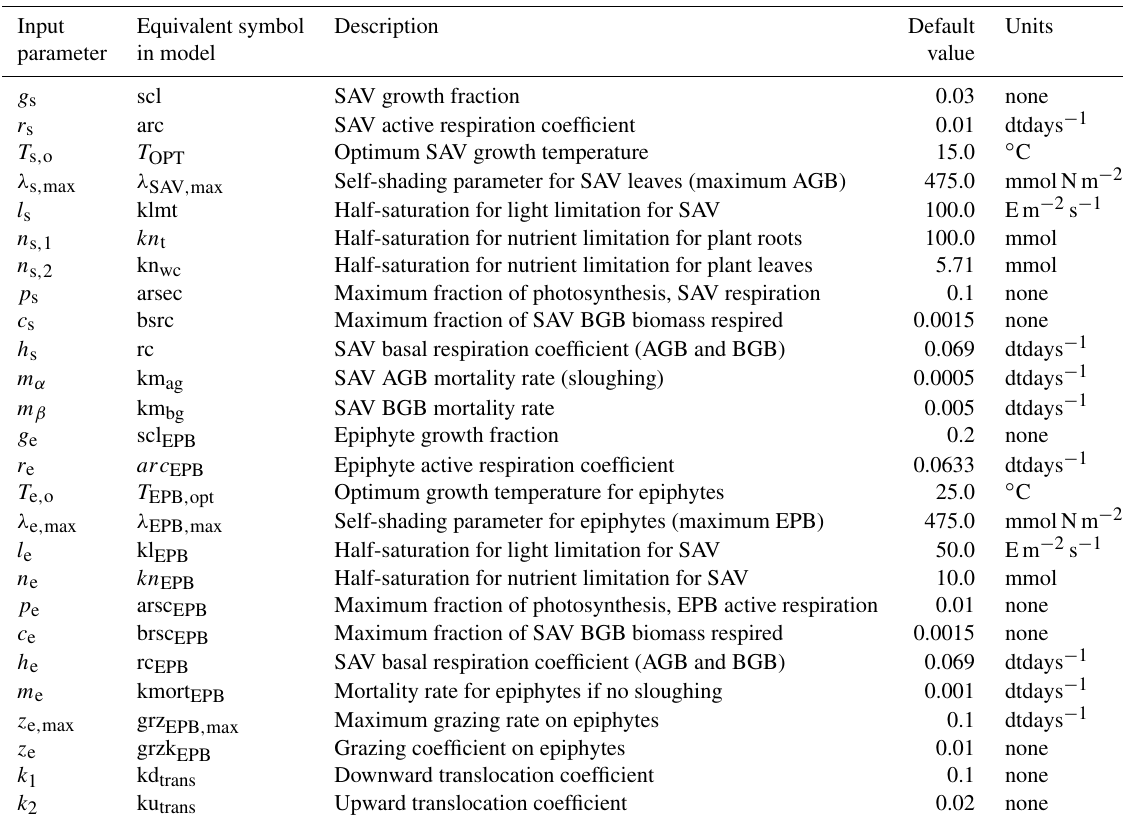
Table 2. SAV growth model input parameter descriptions and their values. Input Equivalent symbol Description